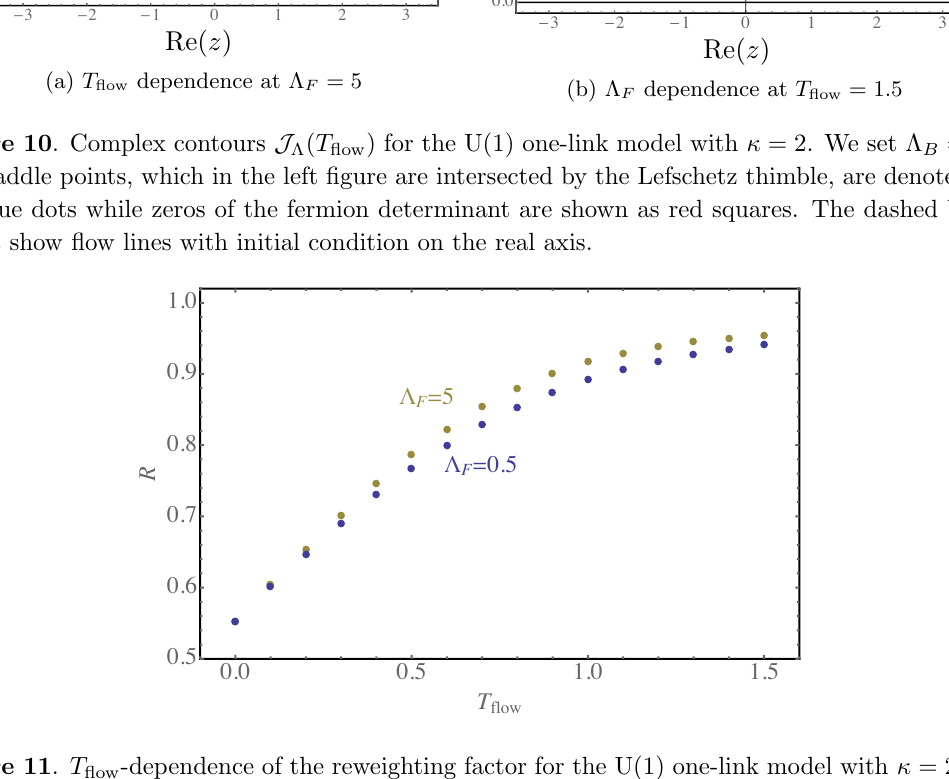
Figure 11 . T (cid:13)ow -dependence of the reweighting factor for the U(1) one-link model with (cid:20) = 2 and (cid:3) B =